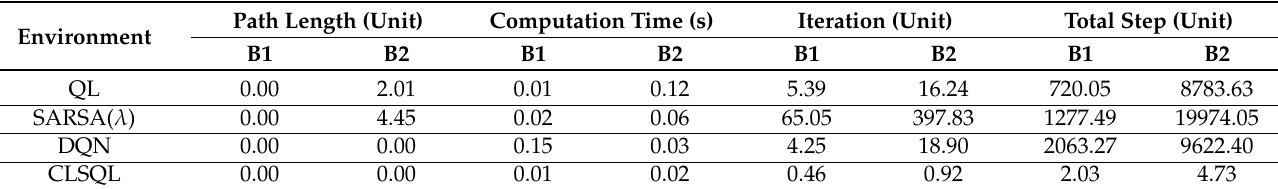
Table 4. Standard Deviation Performance Comparison of Obstacle-free